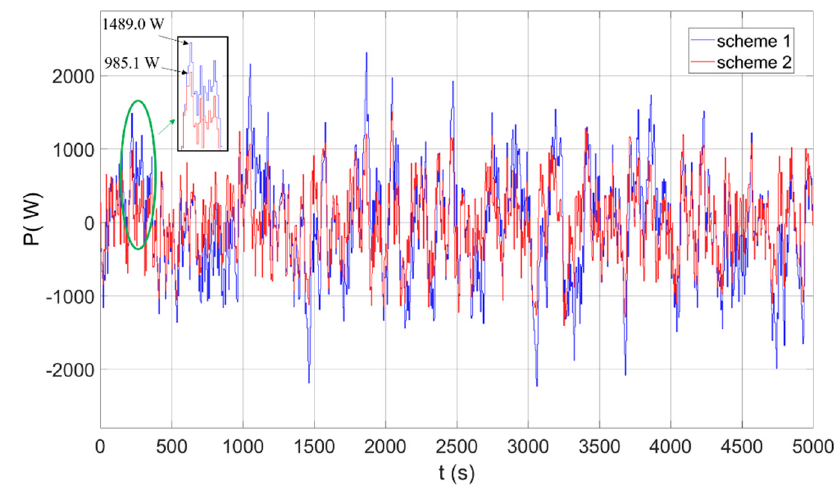
Figure 16. Supercapacitors assumed power comparison.